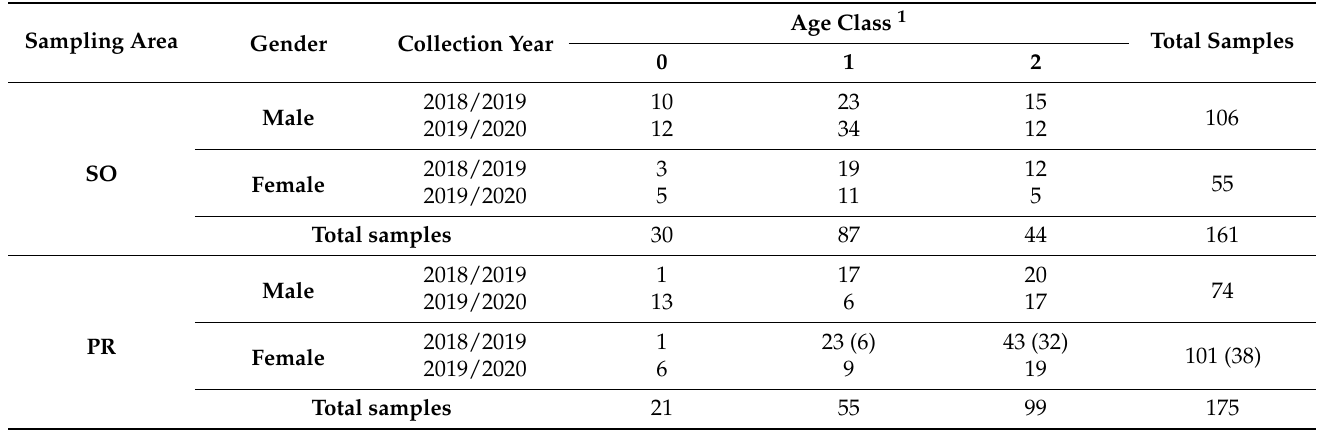
Table 4. Characteristics of the wild boars sampled in the two investigated areas (Sondrio–SO, and Parma–PR). The number of pregnant females is reported in brackets. Sampling Area